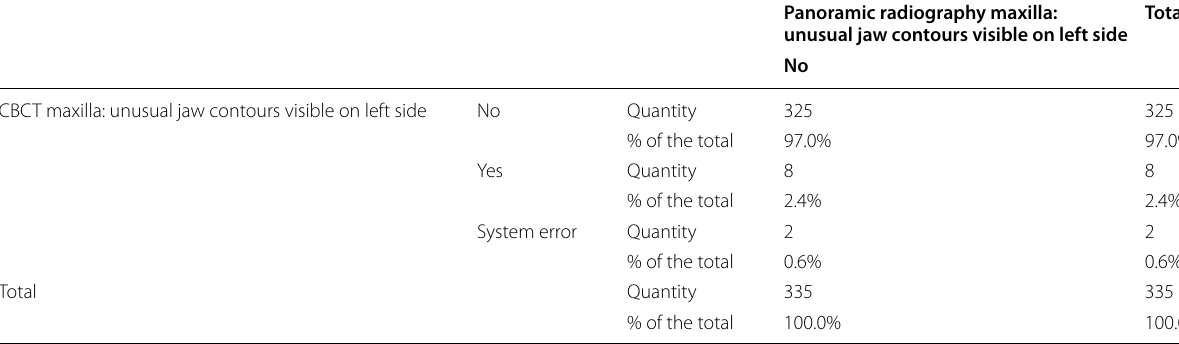
Table 1 Contingency table of unusual jaw contour of the left maxilla in per